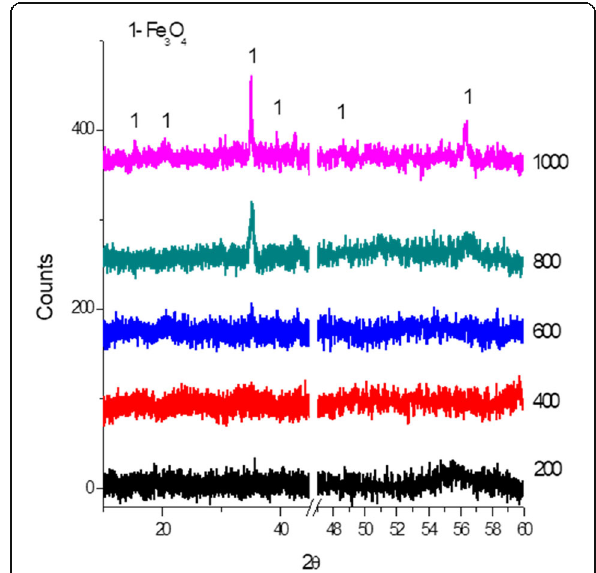
Fig. 1 In situ calcination XRD spectra of Cu – Fe precursors